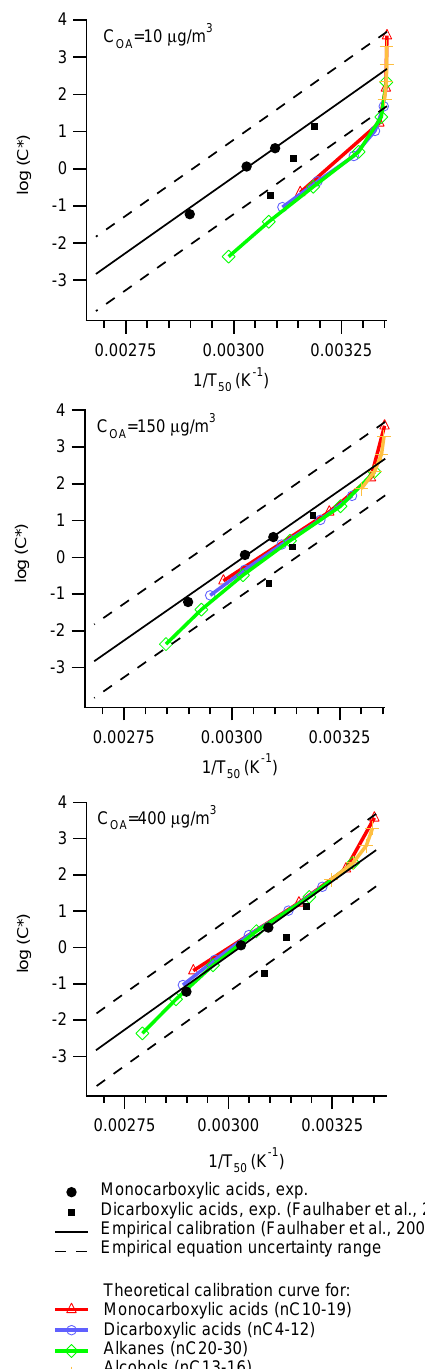
Fig. 11. Theoretical relationship between C ∗ and 1/ T 50 for different 0 organic compounds, as derived from Eq. (22) at different aerosol mass loadings. The empirical and theoretical curves overlap for high aerosol loadings, while deviation between the curves is ex- pected for low atmospheric aerosol